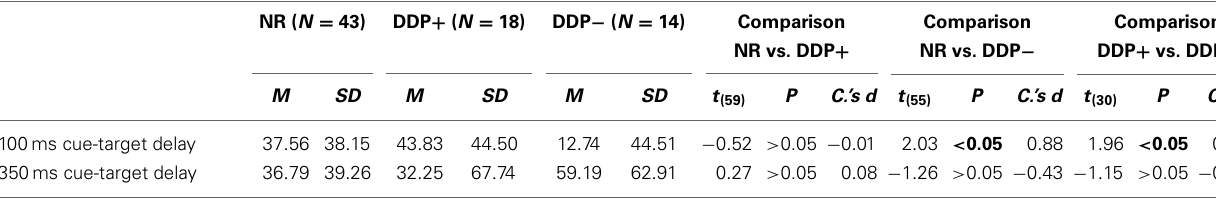
Table 2 | Mean (M) and standard deviation (SD) of cuing effect at 100 and 350ms cue-target